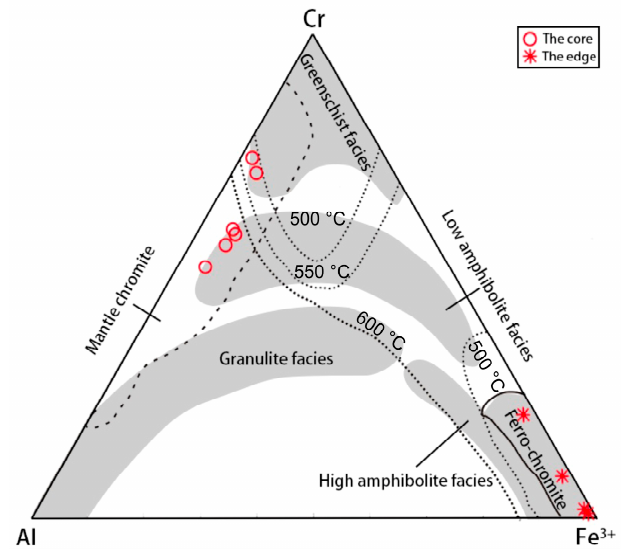
Figure 10. Cr-Al-Fe 3+ graph of metamorphic facies [48] and metamorphic temperatures graph [46] of chromite in “Laoshan Jade”.